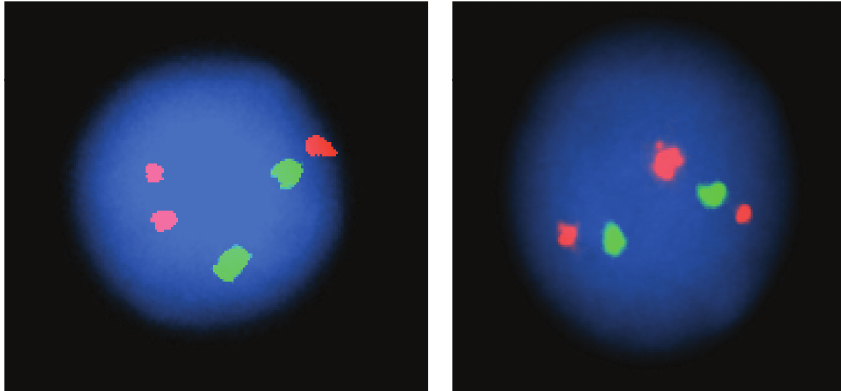
Figure 3: FISH at interphase revealed an extra ABL1 signal, consistent with a rearrangement of the ABL1 locus due to the t(1;9).